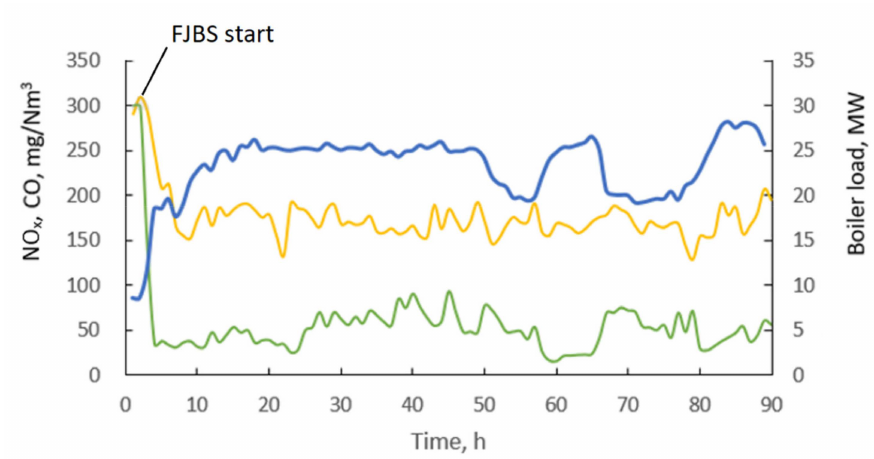
Figure 4. Stack emissions during the FJBS system test run.